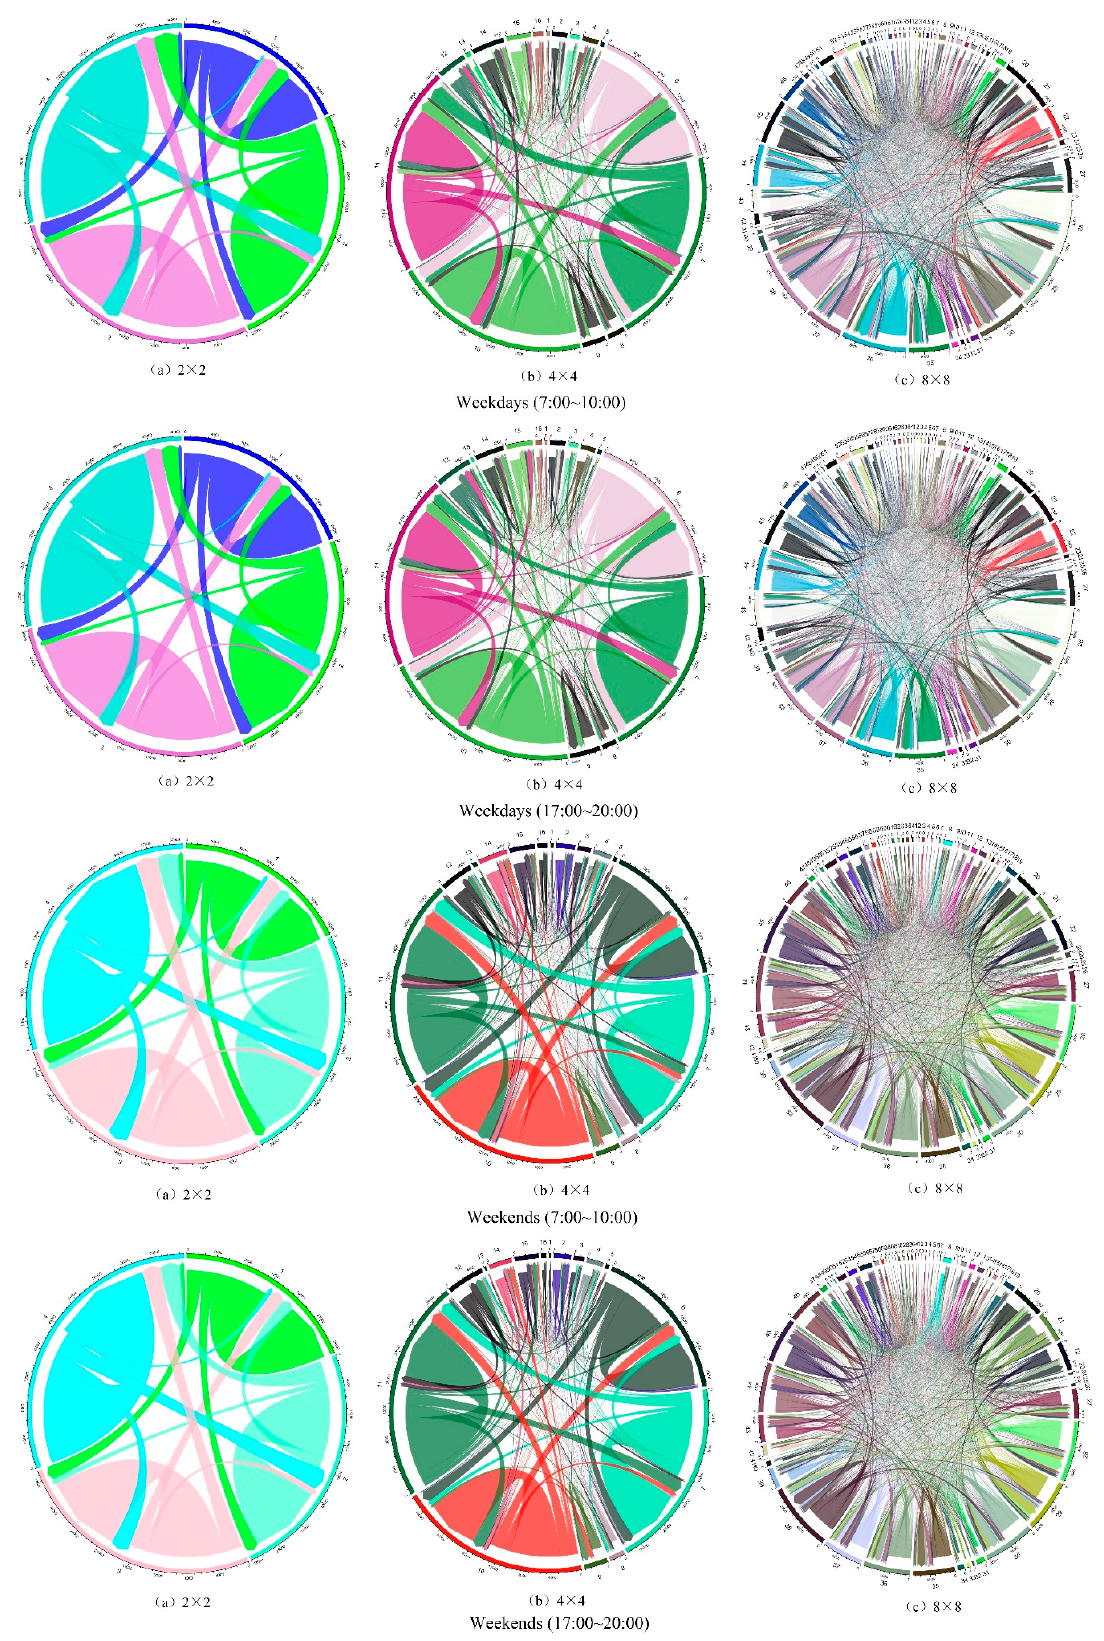
Figure 17. Multiscale expression of taxi OD data space in the rush hour (morning and evening).